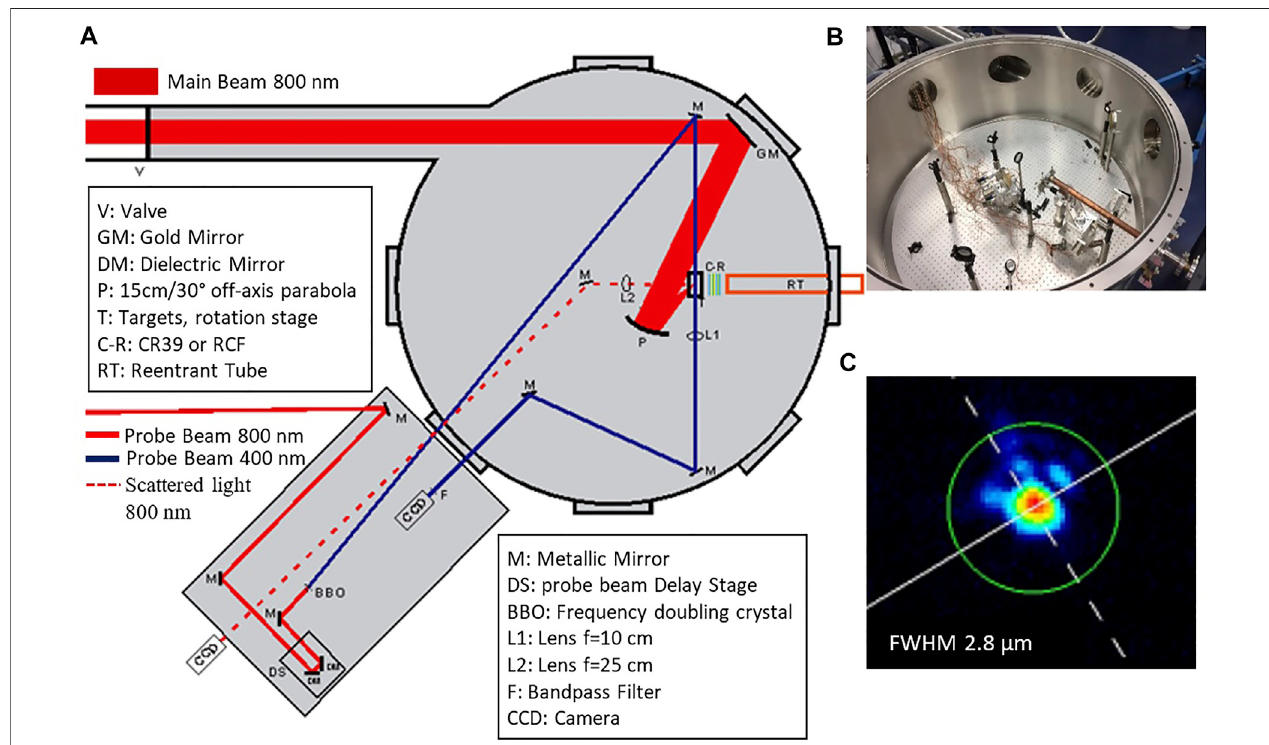
FIGURE 1 | (A) Drawing of the experimental chamber layout illustrating the main beam for laser-solid matter interaction and the probe beam for diagnostics. (B) Image of the experimental chamber where the re-entrant tube is shown to extend close to the target. (C) Image of the focal spot of the main beam focused by the f/2, 15 cm focal length, parabola.